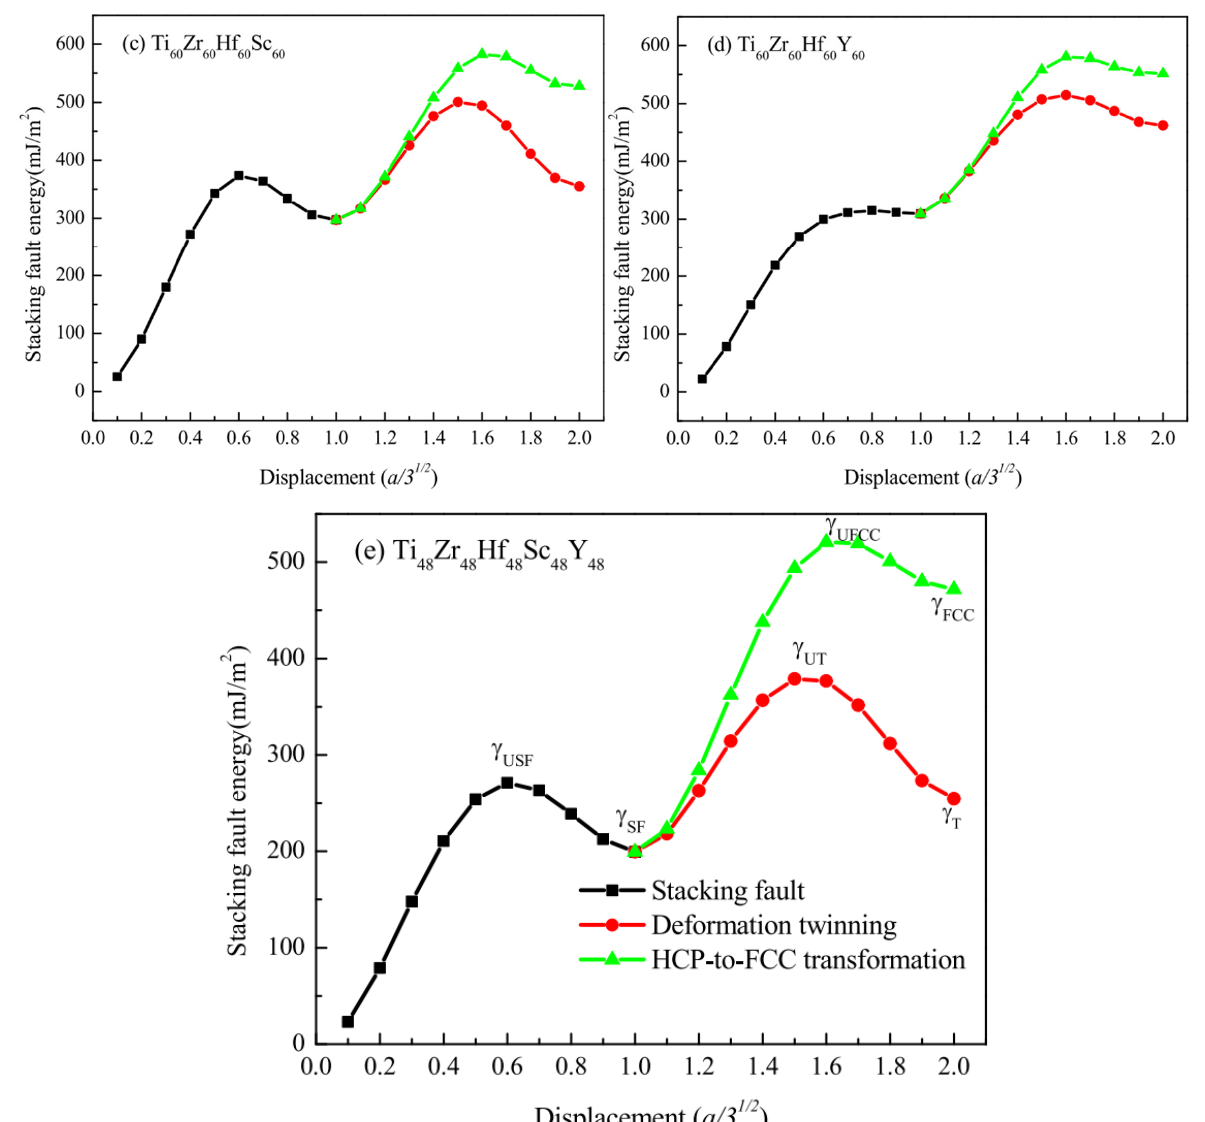
Figure 4. ( a – e ) The generalized planar fault energy curves of the TiZr-based CSAs, where a is the lattice parameter of the system